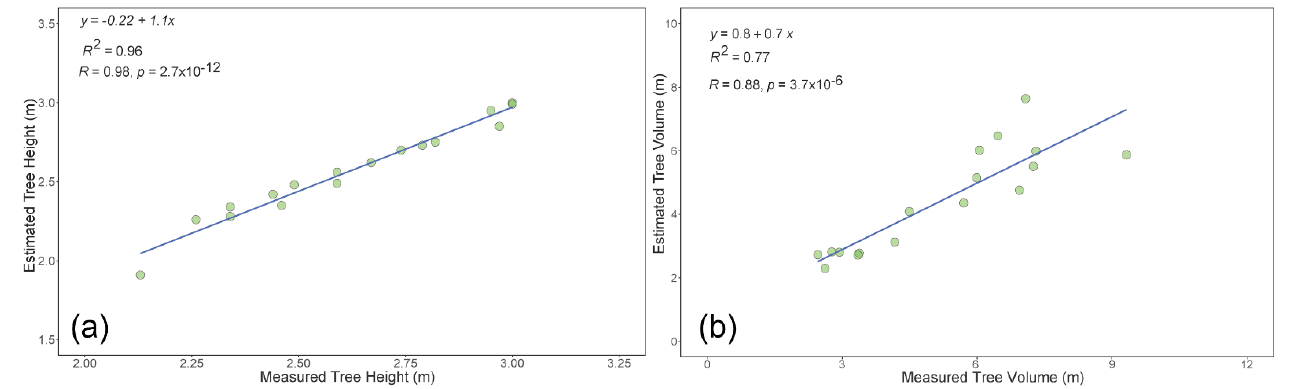
Figure 14. Relationship between the ground reference data with the estimated tree height (a) and tree volume (b) data acquired using the point cloud dataset from the LiDAR system.